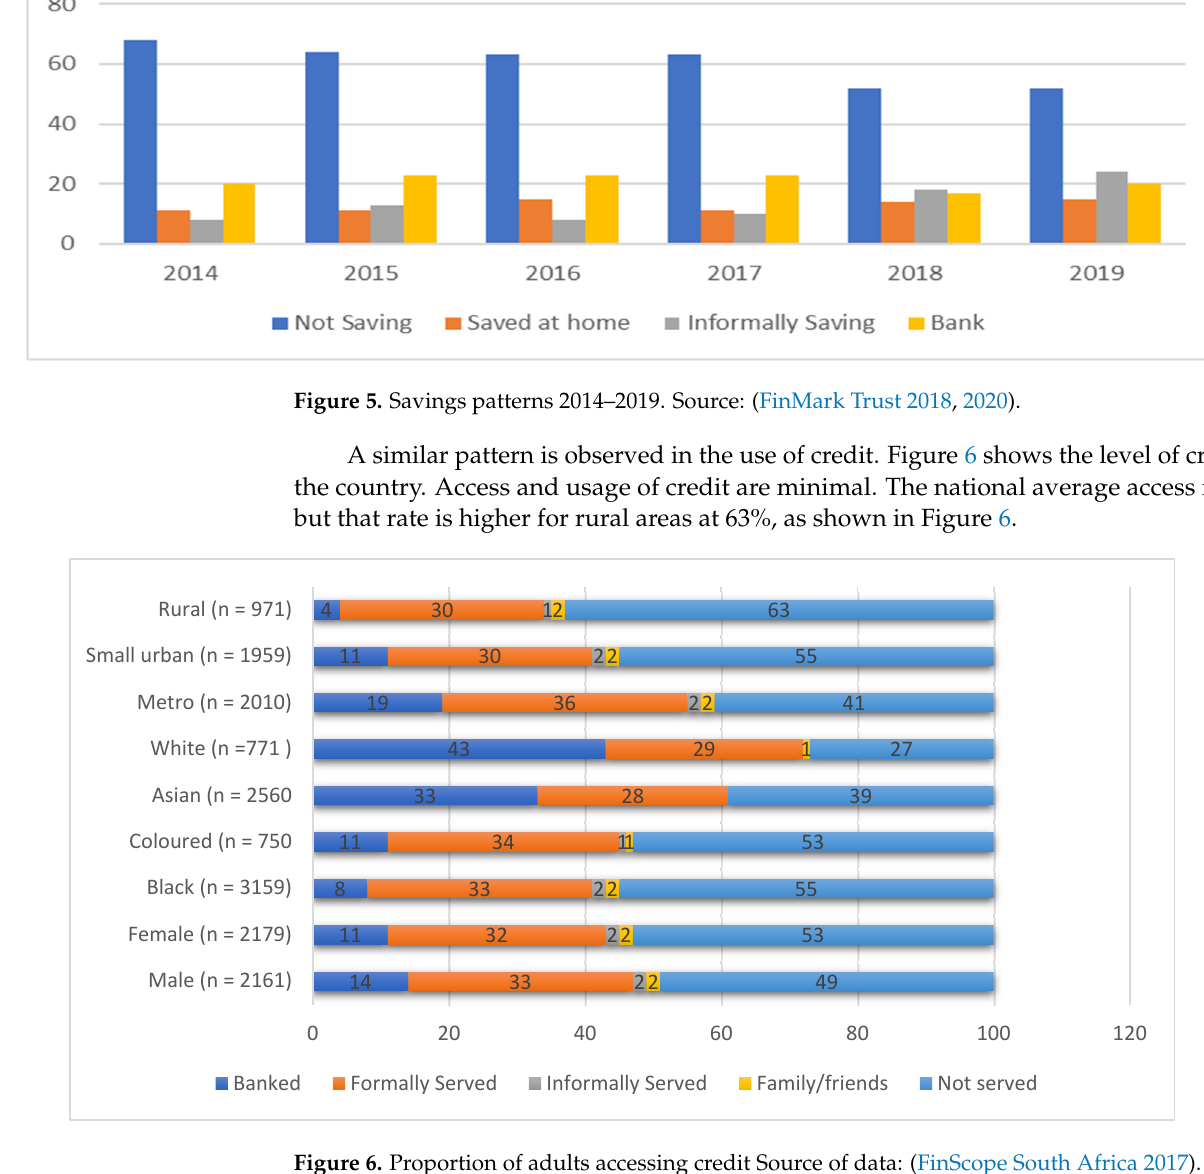
Figure 4. Cash dependency among grant recipients. Source of data: (FinMark Trust 2015, 2016, 2018).